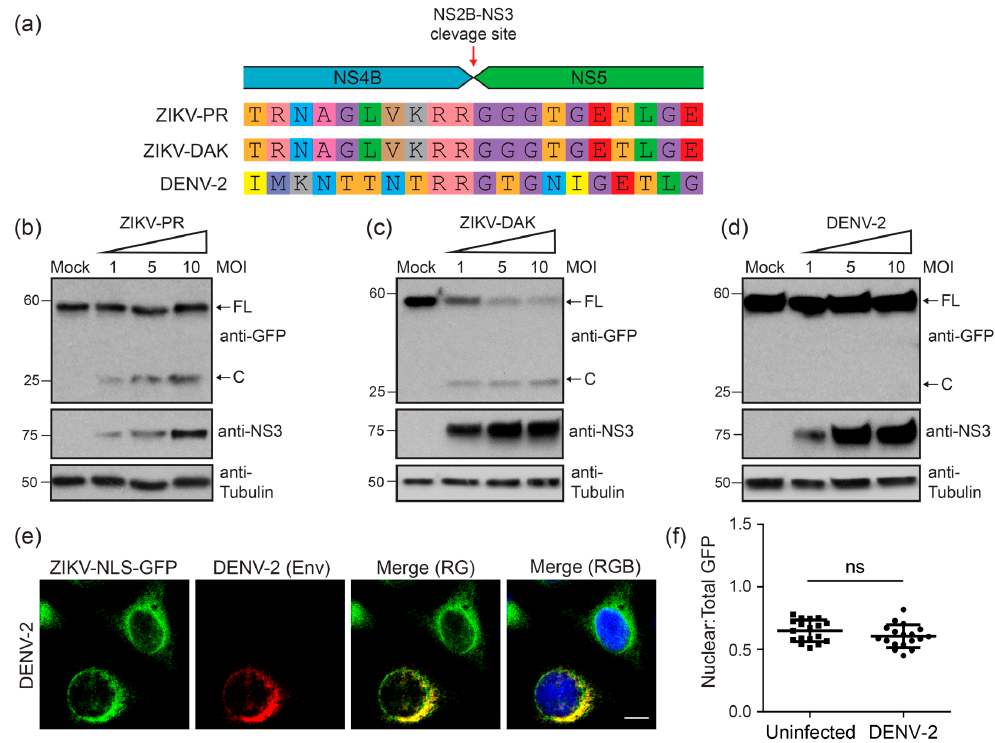
Figure 3. Two divergent strains of ZIKV can both cleave the ZIKV-NLS-GFP reporter. ( a ) Alignment of viral amino acids adjacent to the NS2B-NS3 cleavage site (amino acids 2511–2530 of ZIKV and 2482–2501 of DENV-2), including the Puerto Rico (ZIKV-PR) and Dakar (ZIKV-DAK) ZIKV strains, as well as dengue virus serotype 2 (DENV-2). ( b – d ) Immunoblot analysis of extracts from A549 cells stably expressing ZIKV-NLS-GFP that were mock-infected or infected with an increasing MOI (1, 5, or 10) of ZIKV-PR ( b ), ZIKV-DAK ( c ), or DENV-2 ( d ). Arrows mark full-length (FL) or cleaved (C) ZIKV-NLS-GFP reporter. ( e ) Confocal micrographs of A549 cells stably expressing the ZIKV-NLS-GFP reporter (green) that were infected with DENV-2 (MOI 10) for 48 h and then immunostained for DENV-2 (anti-Envelope (Env); red). Nuclei were stained with DAPI (blue). Scale bar, 10 µ m. ( f ) The ratio of nuclear to total fluorescence intensity, as determined using Image J, in uninfected and DENV-2-infected cells immunostained for DENV Env. Each dot represents an individual cell ( n = 18). Dot plots represent the mean ± SD. (ns) denotes p > 0.05, as determined by an unpaired t -test.